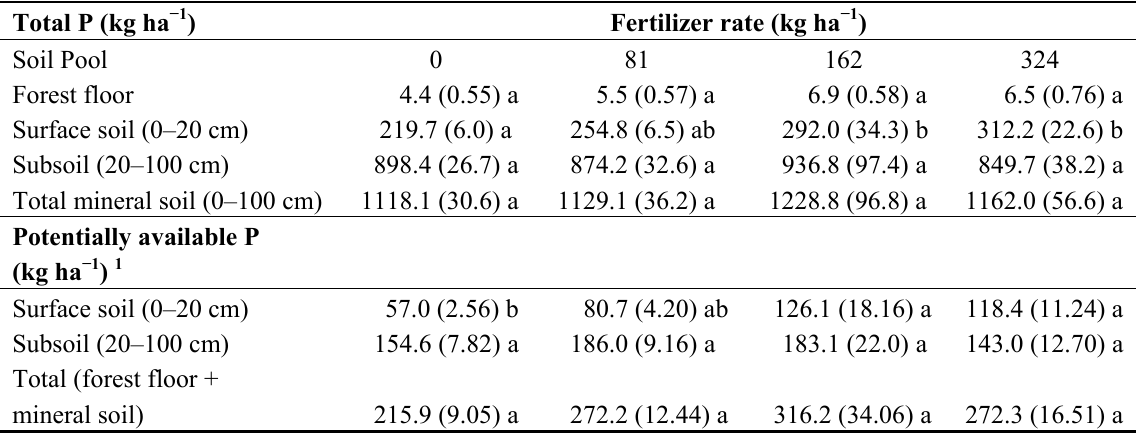
Table 4. Total and potentially available phosphorus (P) recovered in the forest floor and soil to 1 m depth 27 years following fertilization at plantation establishment. Values are means for the whole-plot treatments with standard errors in parentheses. Means within a row followed by different letters are significantly different at p <